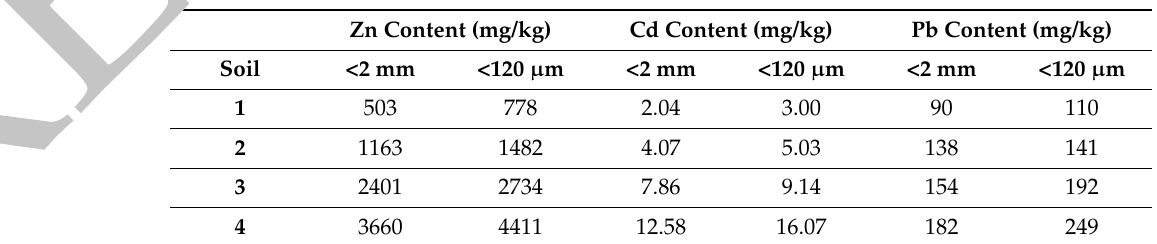
Table 1. Initial metal concentrations in the four soils showing results obtained for both the <2 mm and <120 µ m soil